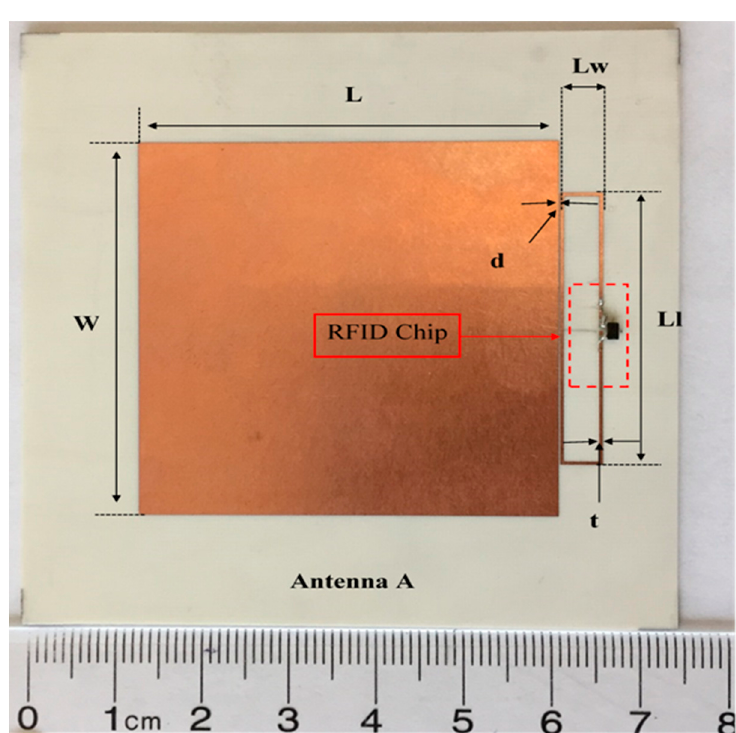
Figure 5. Fabricated antenna. The proposed antenna dimensions are L = 48, W = 47, Lw = 4.8, Ll = 34, d = 0.2, and t = 0.4 (all dimensions are mm).